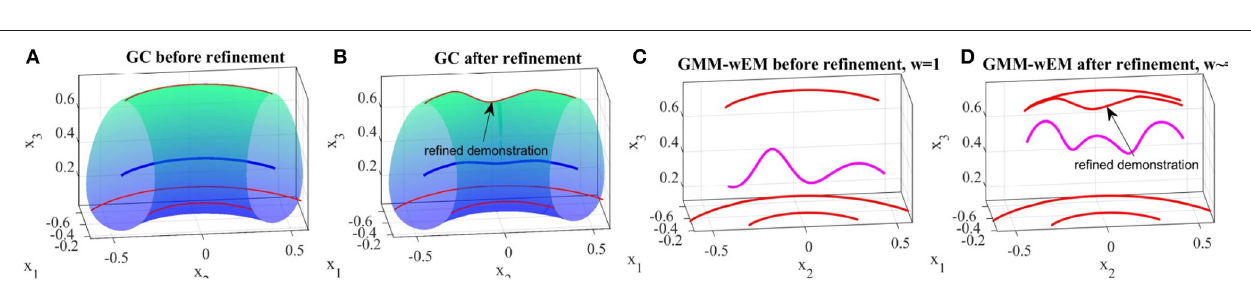
FIGURE 16 | Comparing incremental skill refinement on the reaching skill in section 5.1. (A,B) results using TLGC, (C,D) results using GMM-wEM.